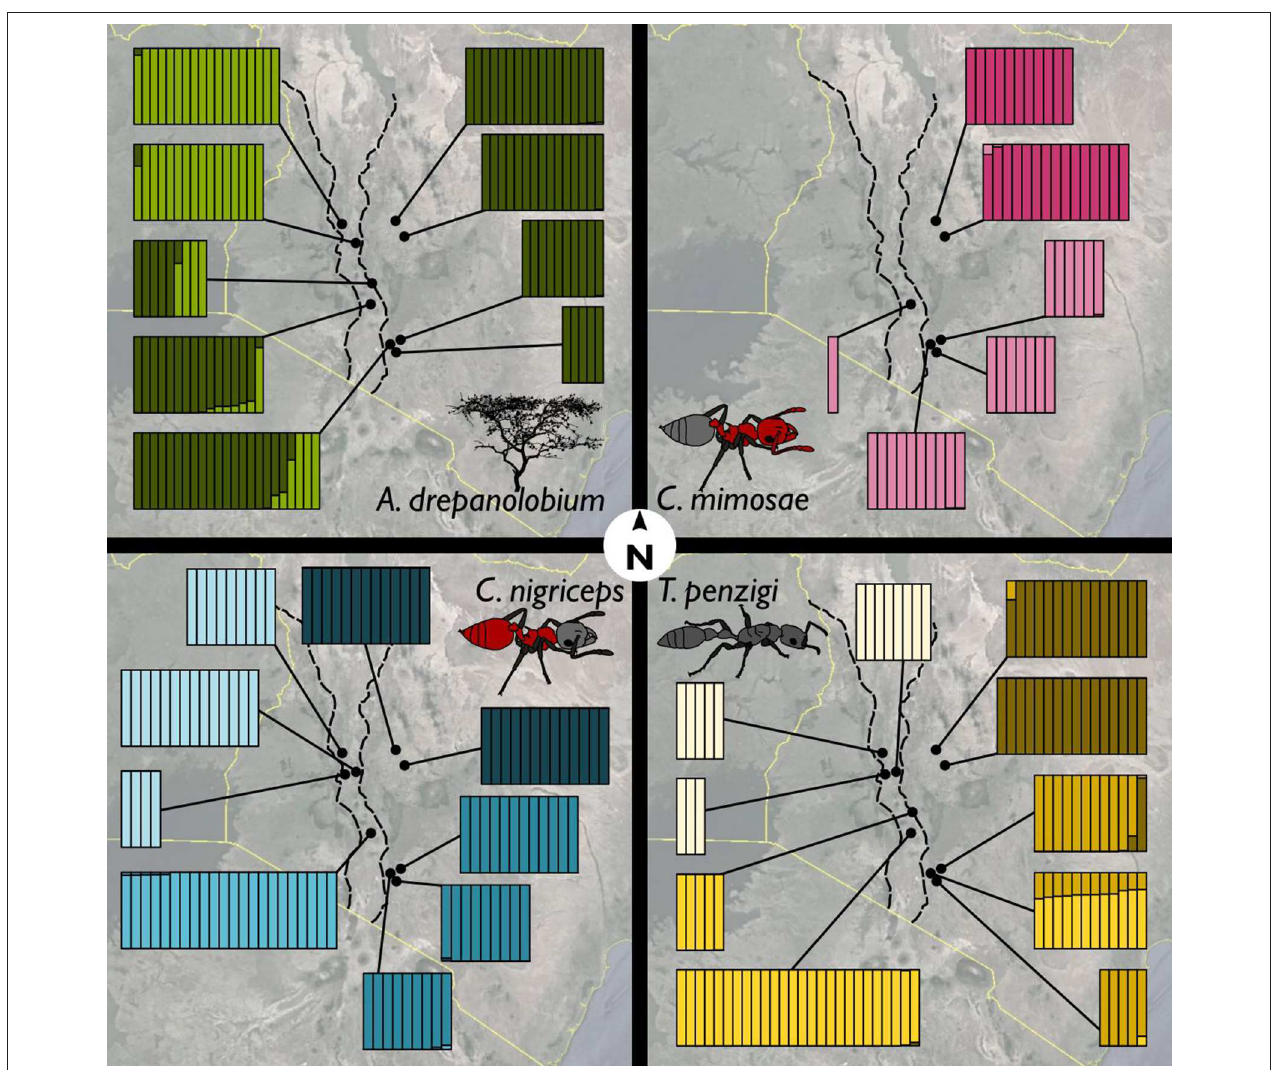
FIGURE 5 | Ants showed more population genetic structuring than did V. drepanolobium . Facets show the Admixture results for (clockwise from upper left) V. drepanolobium , C. mimosae , T. penzigi , and C. nigriceps . Each vertical bar represents an individual tree or ant colony, and is divided up into different colors according to its estimated ancestry proportion of each genetic cluster. The number of genetic clusters for each species was determined via the Admixture cross-validation procedure. Map image: Google, Landsat/Copernicus, US Dept. of State Geographer, Data SIO, NOAA, U.S. Navy, NGA,